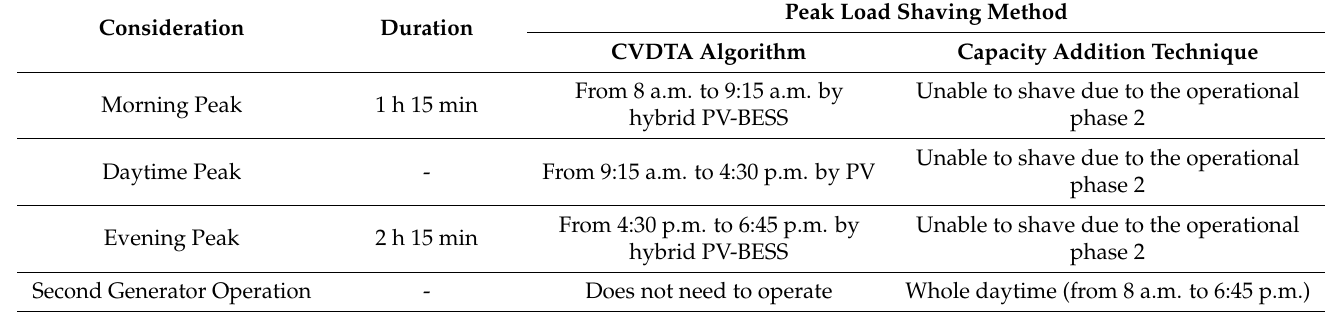
Table 4. Summary of the comparative analysis between the CVDTA algorithm and the capacity addition technique on semester break load